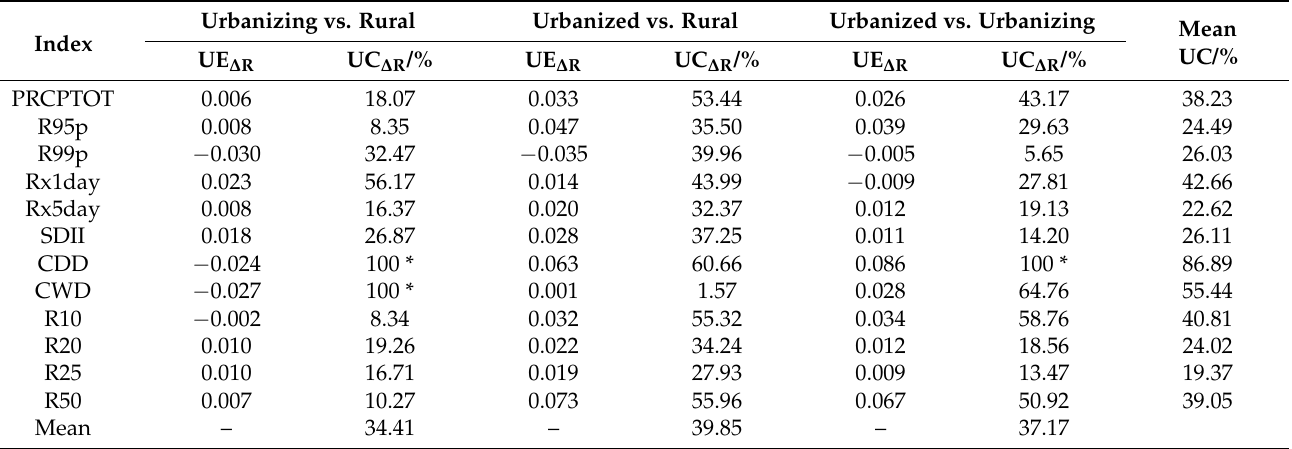
Table 4. Results of urbanization effect and contribution based on the change rate of trends in precipitation